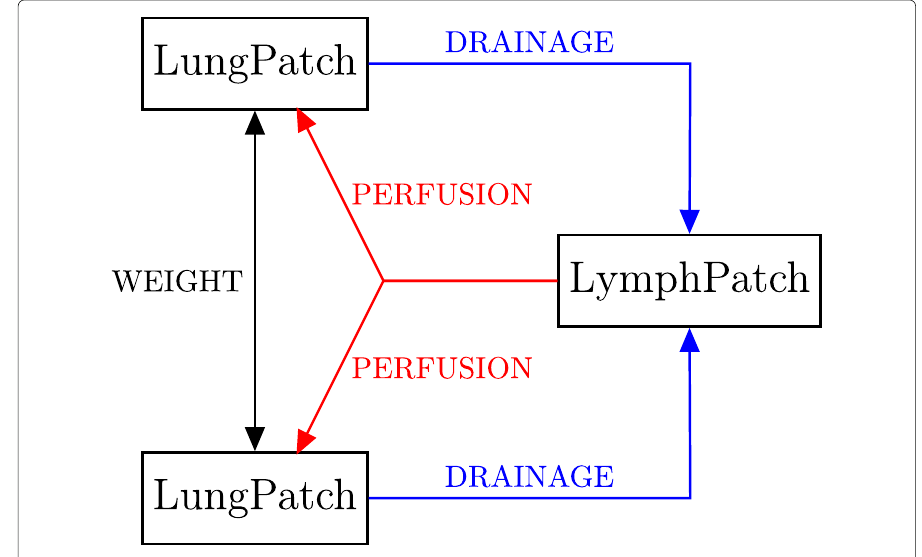
Fig. 2 Diagram of the types of edges used in TBMetapopPy network, along with the attributes of each. LungEdges (in black) indicate movement of bacteria within the air of the lungs, and thus connect two LungPatch instances together, with a WEIGHT value indicating probability of movement. LymphaticEdges (in blue) indicate the migration of cells from the lung to the lymphatic system, and connect a LungPatch to a LymphPatch. DRAINAGE indicates the flow rate of cells to the lymphatic system. BloodEdges (in red) indicate the movement of bacteria and cells into the lung via the bloodstream and thus connect a LymphPatch to a LungPatch. These edges contain a PERFUSION value, set equal to the perfusion value of the LungPatch